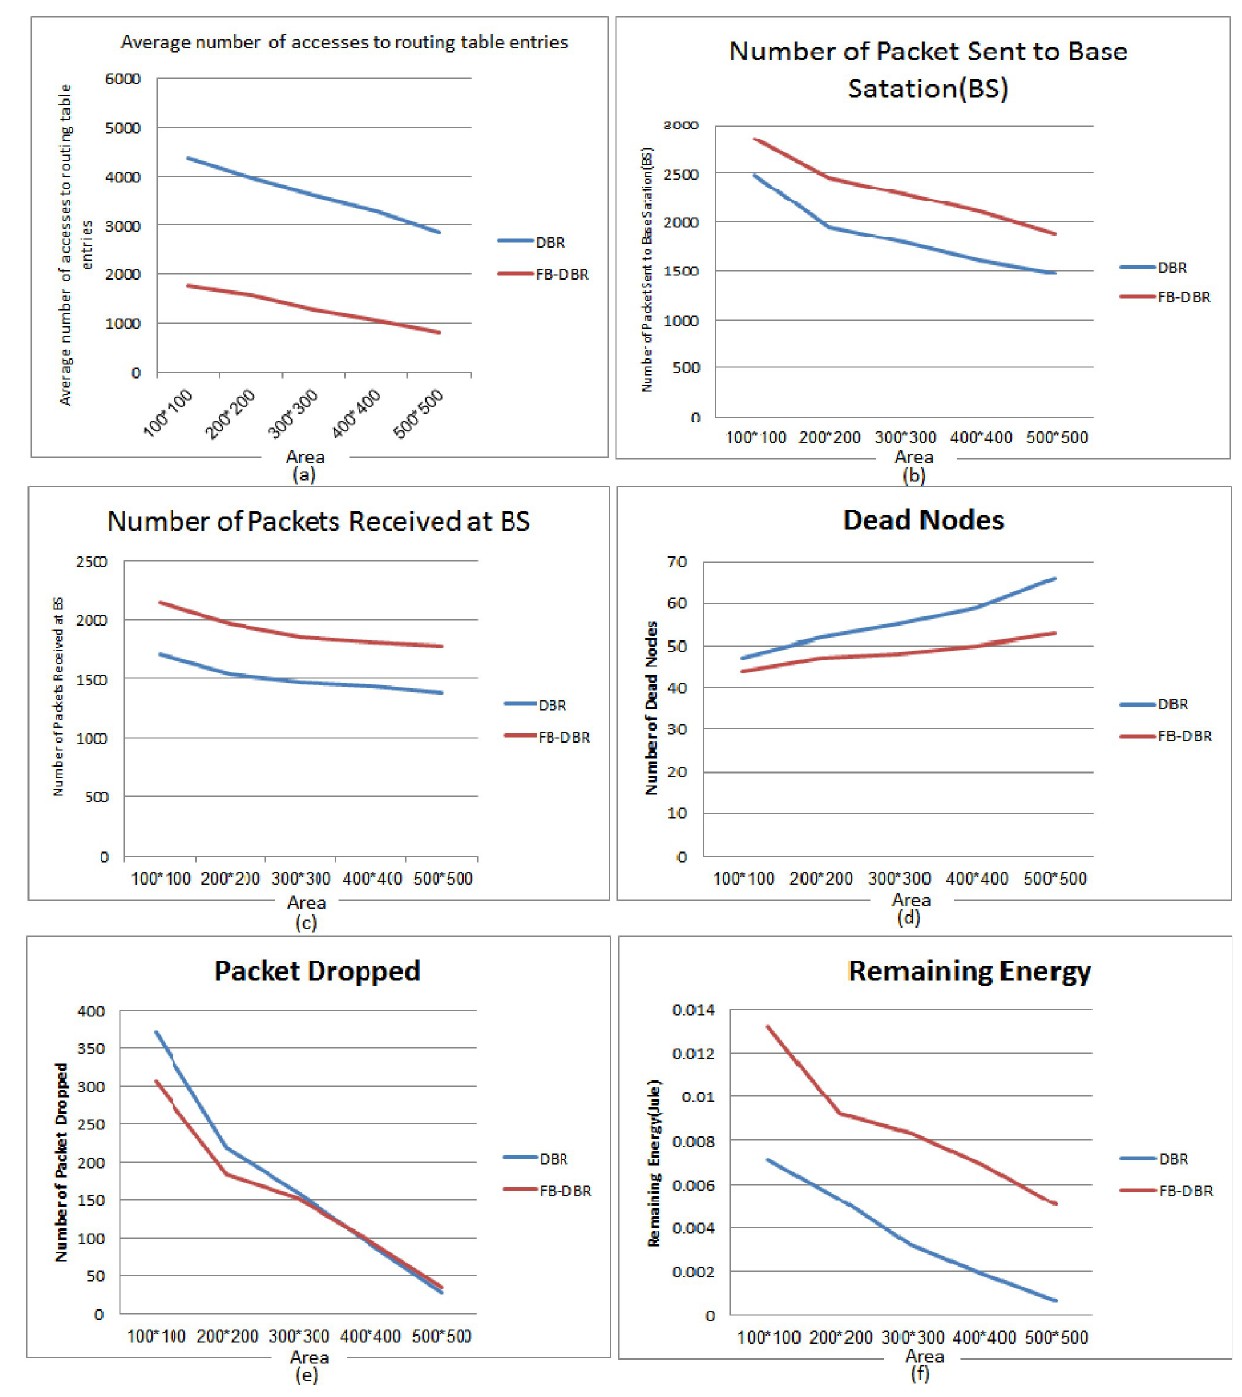
Fig 8. FB-DBR and DBR outputs based on